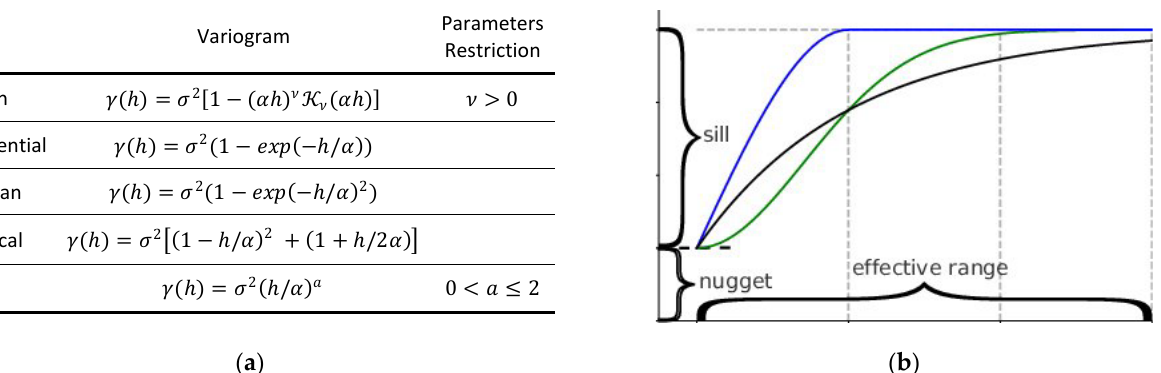
Figure 1. Examples of parametric families of theoretical models for experimental variograms fitting ( a ); comparison of spherical (upper function), Gaussian (intermediate function) and exponential (lower function) models ( b ). Modified from Mälicke et al. [44].